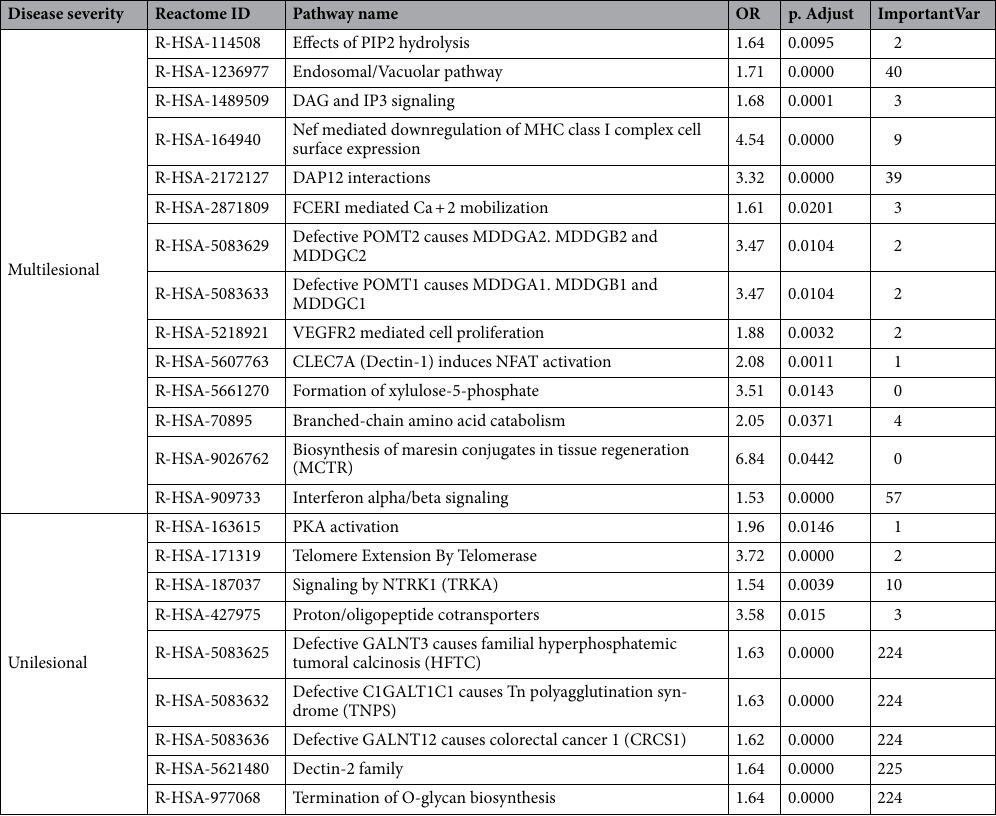
Disease severity Reactome